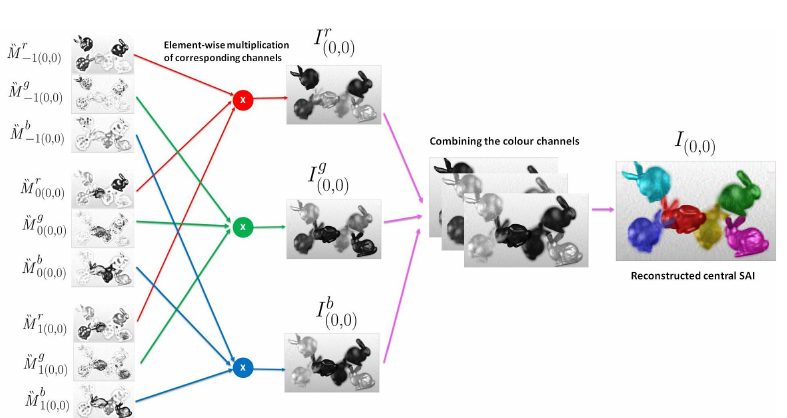
z ( 0,0 ) . The . The final central light field view I ( 0,0 ) is 0,0 )